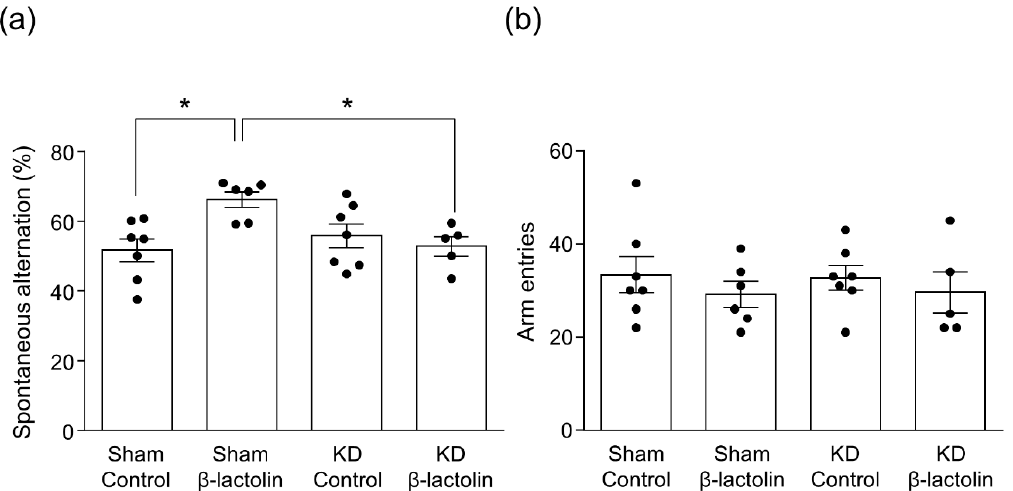
Figure 2. Knockdown of dopamine D1 receptor in the hippocampus abolished the effect of β -lactolin on spatial working memory in the Y maze test. Hippocampal DA D1 receptor knockdown mice or control-knockdown mice were orally administered β -lactolin (0 or 1 mg/kg) and intraperitoneally administered with scopolamine (0.8 mg/kg) after 40 min. Mice were tested on the Y-maze 60 min after oral administration. Spontaneous alternation behavior ( a ) and the number of arm entries ( b ) during the 8 min of the test were measured. Results are presented as the mean ± SEM ( n = 5–7 mice per group). * p < 0.05 versus each group.